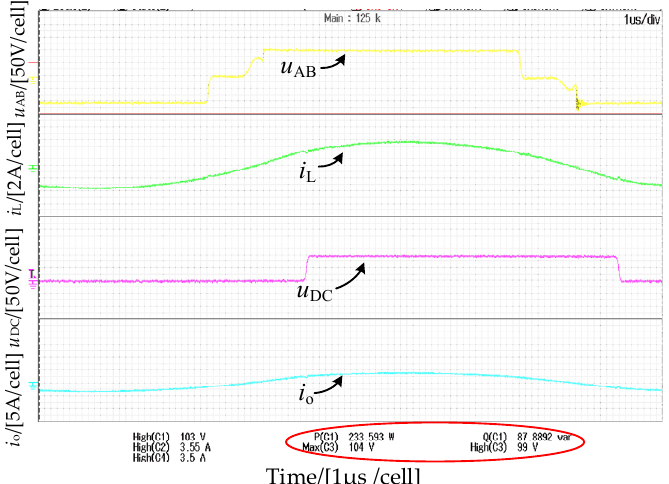
Figure 36. ϕ AD = 57 ◦ and ϕ AB = 213 ◦ experimental waveforms with reactive power optimization control. It can be seen that the combination of the phase-shift angle of the output of the reactive power flow diagram is located near the soft-switching boundary of the B-bridge arm,